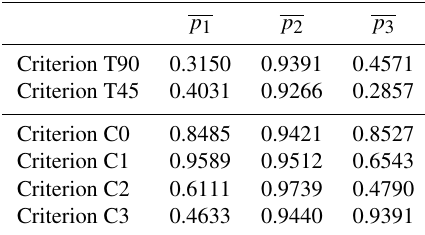
Table 2. Values of indicators for each criterion